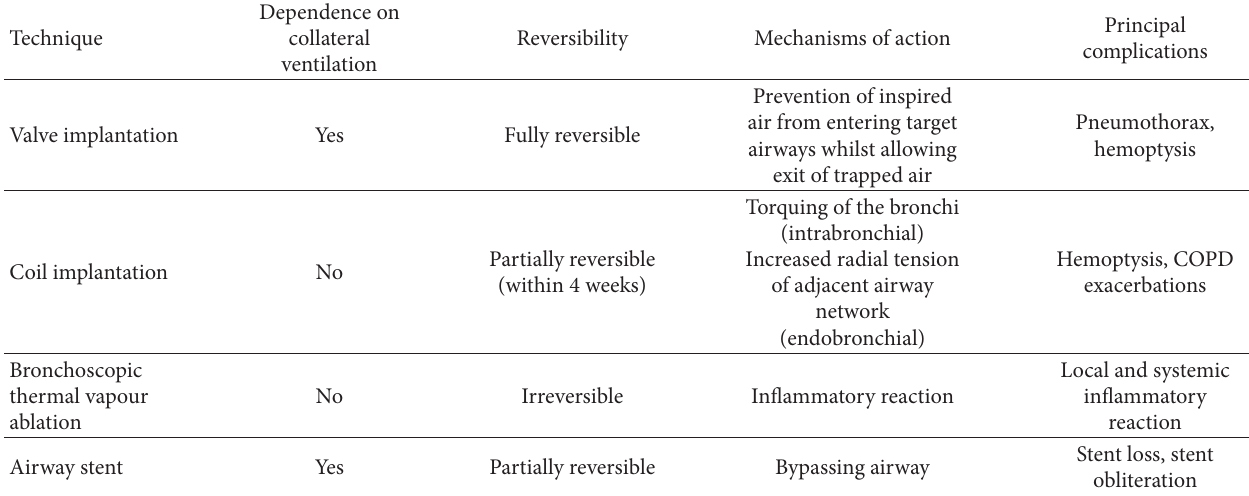
Table 1: Overview of the currently available procedures for lung volume reduction (LVR) in advanced